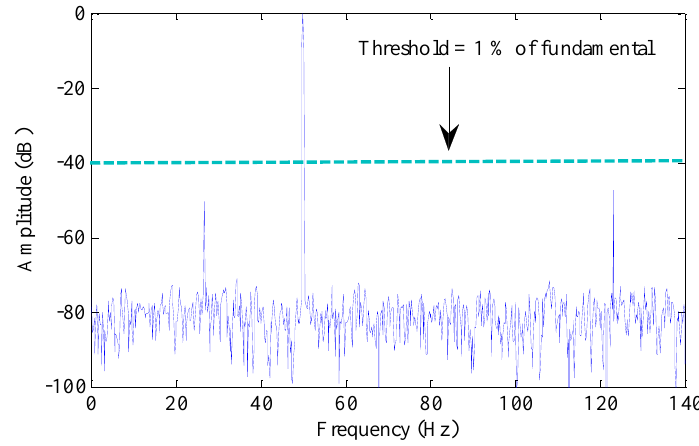
Figure 10. The predetermined threshold defined based on the % of the fundamental signal [38].